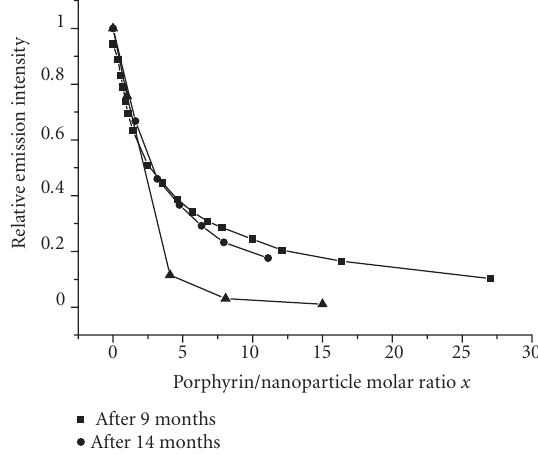
Figure 1: Absorption (1) and PL (2) spectrum of YQD in toluene. Absorption (3) and fluorescence (4) spectrum of THP in toluene.